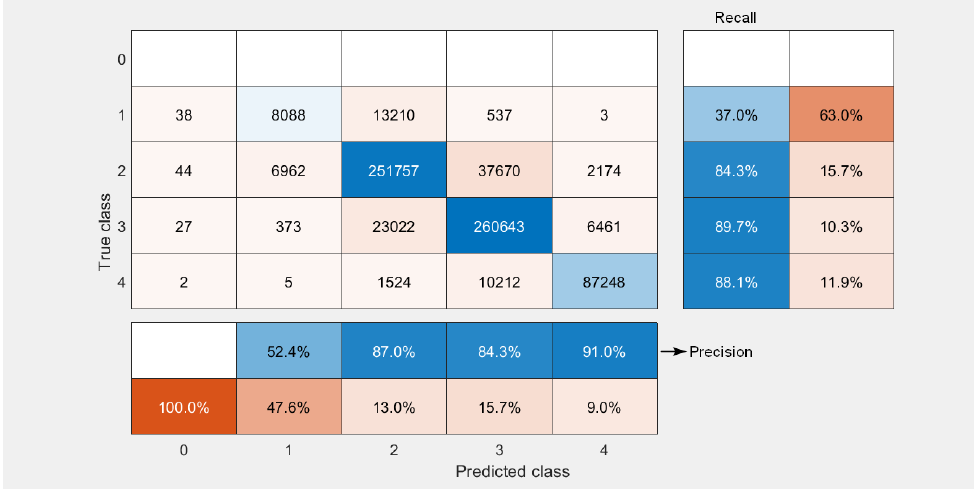
Figure 4. Confusion matrix for qualitative severity rating scale